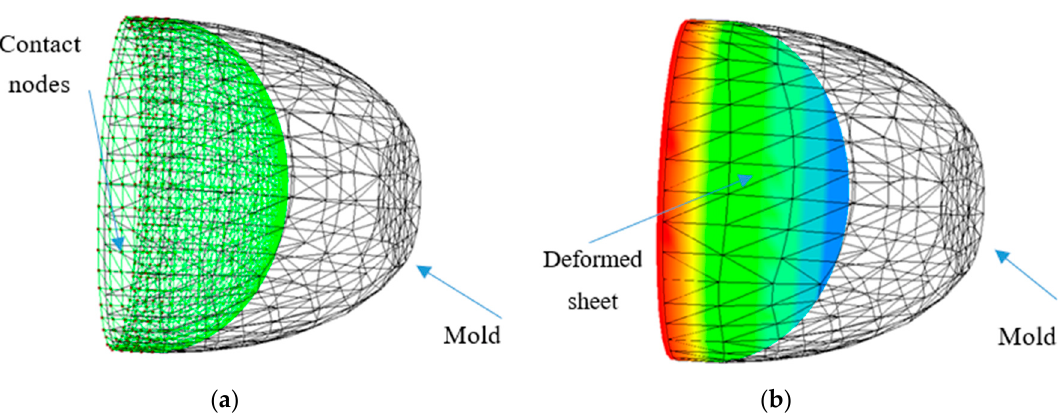
Figure 15. Shape of the deformed MD and principal stretch λ 3 in the time-critical neighborhood 0.06 s. ( a ) Final shape of the deformed MD. ( b ) Distribution of the principal extensions λ 3 in the final deformed MD.